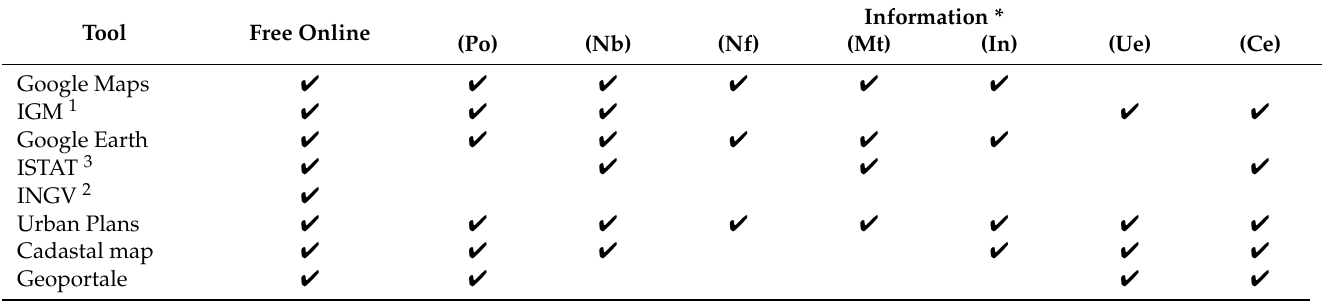
Table 1. Web tools for remote building survey and